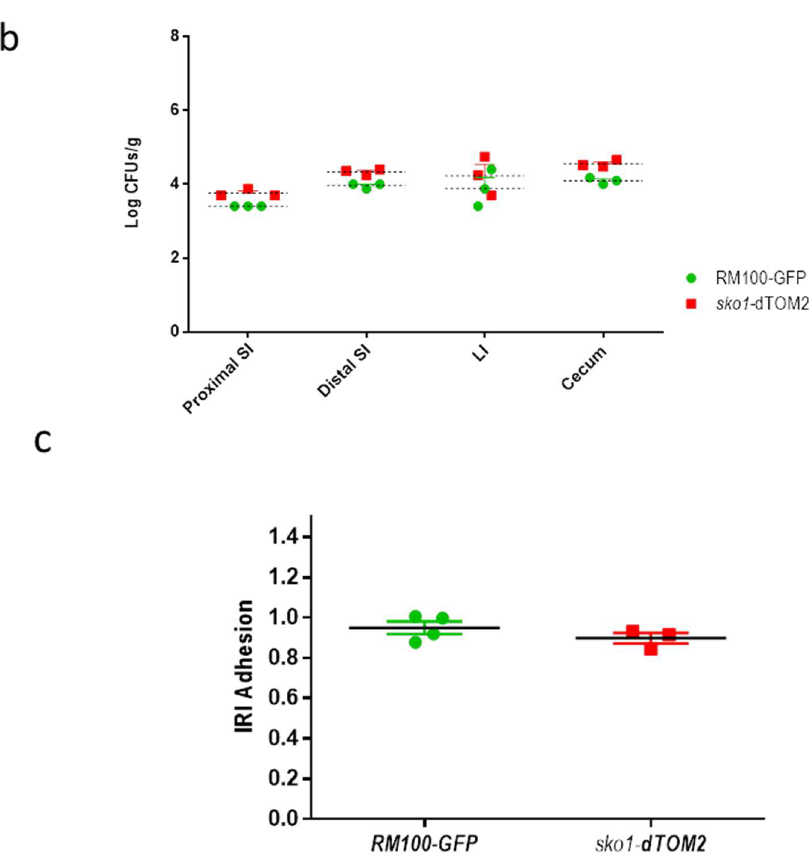
Figure 1. Role of Sko1 in murine gut colonization. a ) C57BL / 6J mice were treated with a combination of antibiotics for 1 week to reduce bacterial microbiota. Then, 10 7 C. albicans cells in 100 µ L of a balanced mix of sko1 -dTOM2 and wt-GFP cells were inoculated intragastrically. The graph represents Log CFUs / g of faeces across time. Each square represents a single mouse ( n = 3); b ) At day 24, mice were euthanized and their intestine was split on proximal small intestine (SI), distal small intestine, large intestine (LI), and cecum. Samples were processed and C. albicans colonies were counted. Each single independent value is represented as the mean ± SEM from three mice; c ) Adhesion to intestinal mucosa was assayed using a mix of wt-GFP / wt-dTOM2 tagged strains as internal control and a mixture of wt-GFP and sko1 -dTOM2 strains as samples. C. albicans mix was allowed to adhere to clean murine gut mucosa for 150 min and then the Adhesion Relative Index was calculated by dividing the percentage of adhered cells from wt or sko1 strains labelled with the red fluorescence protein, which was recovered after 150 minutes of interaction with gut mucosa, by their percentage in the inoculum. Each point represents an individual assay.